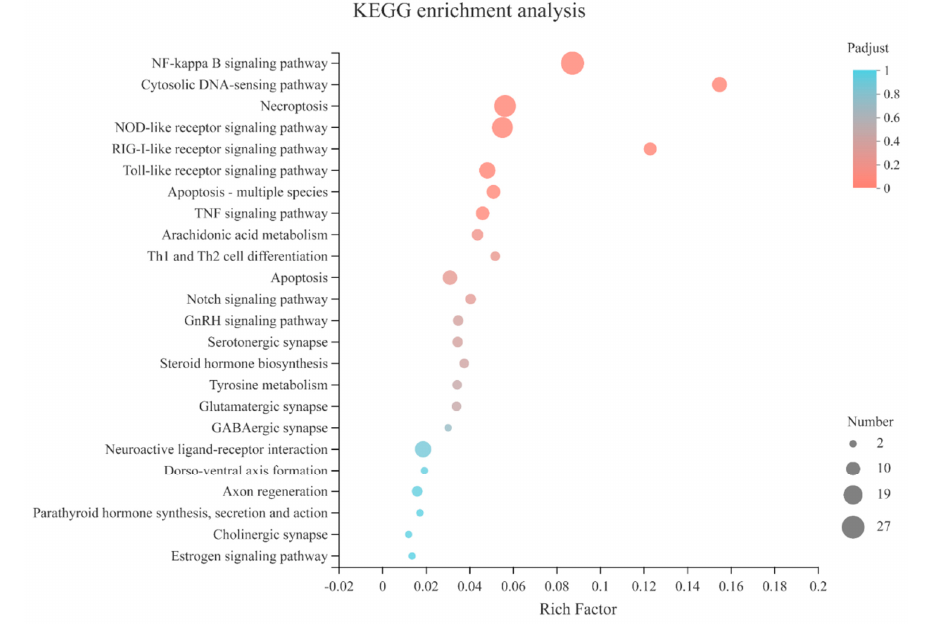
Figure 4. KEGG pathway enrichment scatter plot of the DEGs. The vertical axis represents the path name, and the horizontal axis represents the path factor corresponding to the rich factor. The color of the point represents the size of the p − value. The smaller the p − value, the closer the color is to red. The number of differential genes included in each pathway is presented by the point’s size. 3.3. qPCR Analysis of Differential Gene Expression during Development of Mussel Thirteen genes highly expressed in the pediveliger stage with >two-fold difference in expression compared to all other stages and of functional interest were selected to corrob- orate the outcome of the transcriptome data by qPCR (Table S1, Figure 5). All the selected genes, such as neuropeptide FF receptor 2 ( NpffR2 ), estrogen receptor ( EsR ), byssal tyro- sinase-like protein 2 ( Btyp2 ), caspase-3-like 1 protein ( CASP3 ), toll-like receptor W ( TLRW ), neurogenic locus notch homolog protein 1-like isoform X2 ( Notch1 ), and arachi- donate 5-lipoxygenase isoform X1 ( Alox5 ), were significantly increased at the pediveliger stage relative to other stages (Figure 5, p < 0.05). Most of the genes revealed a similar ex- pression pattern compared with the RNA-seq data.